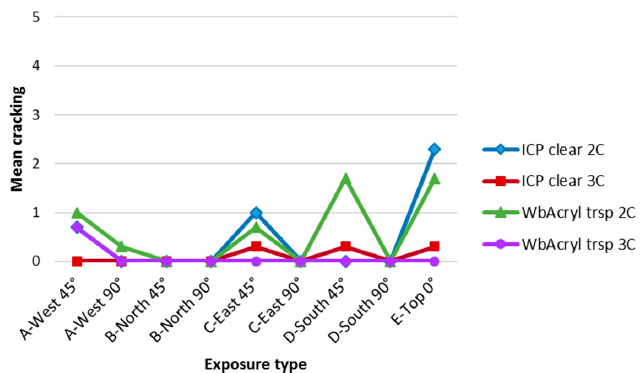
Figure 13. Influence of cardinal direction and the angle of exposure on the moisture content of samples coated with the ICP clear (two coats) exposed on the MFER.